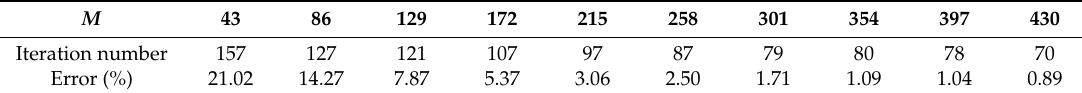
Table 3. The relations of M with the reconstruction error and the computation complexity during the reconstruction of the complex gas signal.